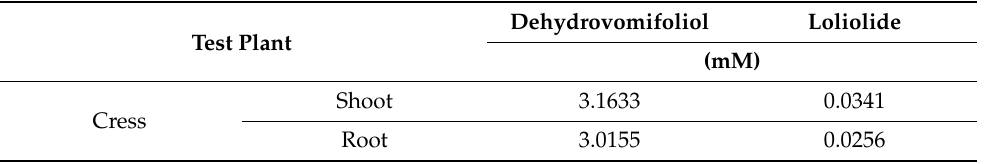
Figure 6. The phytotoxic effects of loliolide on the growth of the cress seedling. The mean ± standard error from the two independent experiments with three replications (10 seedlings per replication) for each experiment is presented. Different letters denote the significant differences according to Tukey’s HSD test at a 0.05 probability level. Table 2. The concentration needed for the 50% inhibition of growth (I 50 values) of the tested plant by dehydrovomifoliol and